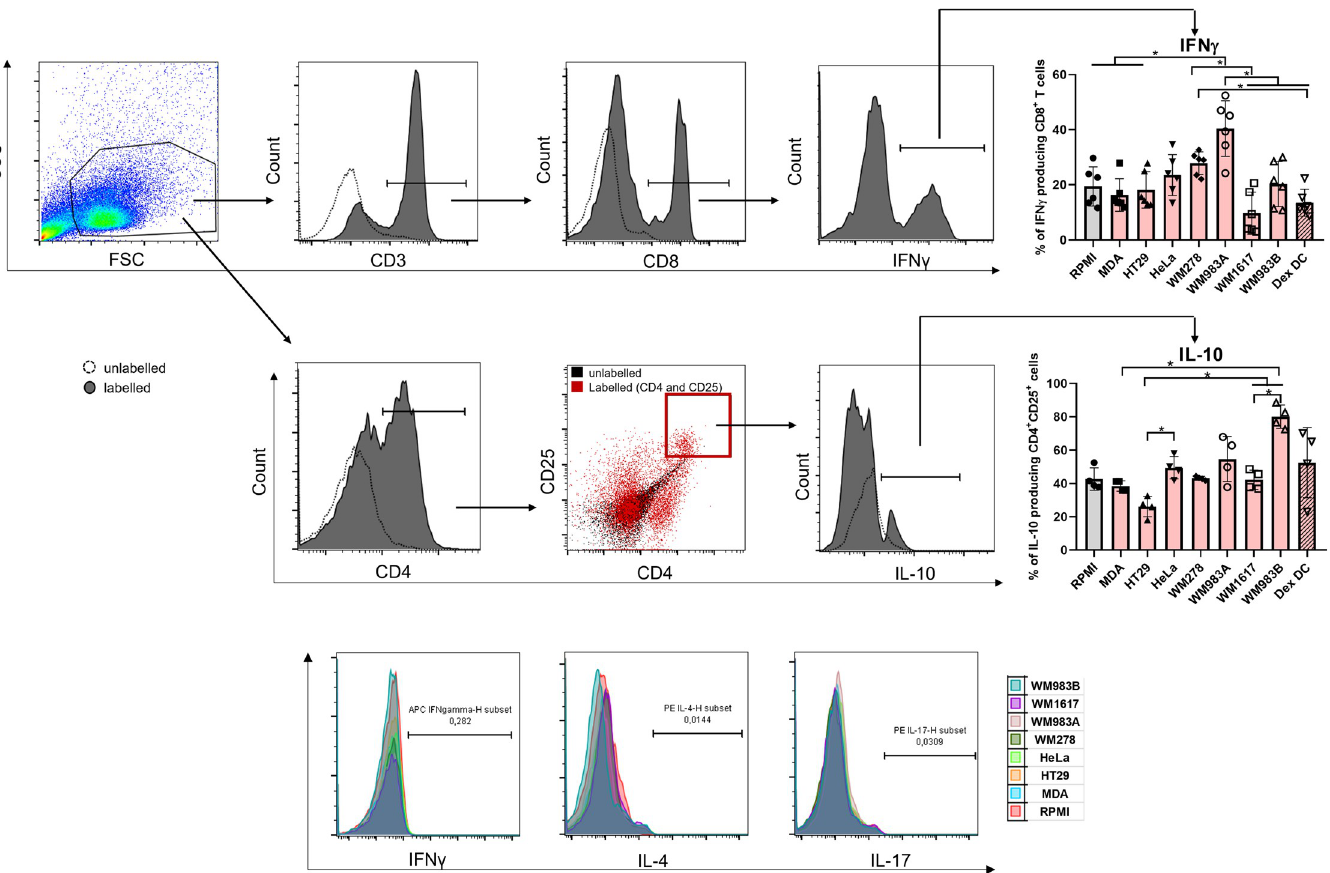
Fig 5. Tumor cell line-educated moDCs polarize the T cells in different ways. CD14 + monocytes were cultured with 100 ng/ml IL-4, 80 ng/ml GM-CSF ± MDA-MB231-, HeLa-, HT29-, WM278-, WM1617-, WM983A- or WM983B-CM for four days. Control or TU-CM-moDCs were co-cultured with autologous peripheral blood lymphocytes (PBL) for three, five, or nine days in RPMI-1640 medium at a ratio of 1:10 (moDCs: T-cells). The cytokine production capacity of T cells was measured by flow cytometry. The figure shows the mean plus SD of the populations positive for the measured surface molecules and cytokines calculated from at least six/ four independent experiments. Histograms or dot plots show one of the six/four independent experiments. Significance is indicated by � P < 0.05, �� P < 0.01, ��� P < 0.001.